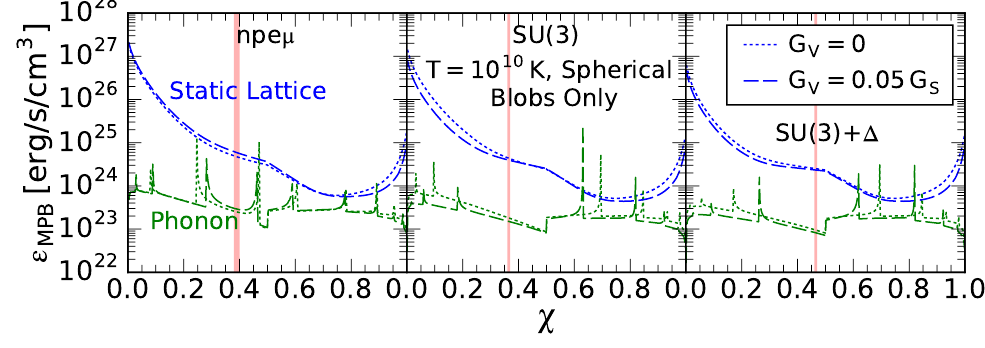
Figure 8. Comparison of the static lattice and phonon contributions to the neutrino emissivity at T = 10 10 K for the spherical blob geometry only and the DD2 parametrization [7].